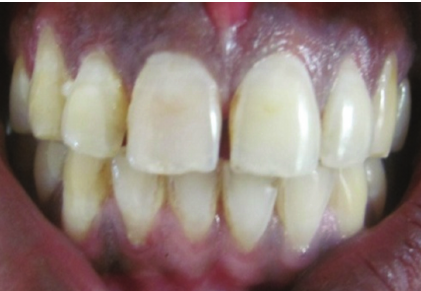
Figure 19: Splint removal and